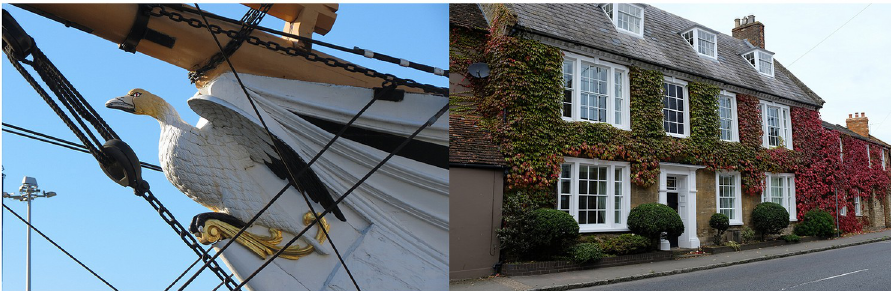
Fig 4. Common cases of false positive and false negative: False positive for Marus bassanus (Gannet) (left) tags: Bird, goose, vehicle, tall ship and false negative for Hedera helix (Ivy) (right): Tags: Property, house, home, building, residential area, cottage, real estate, neighbourhood.